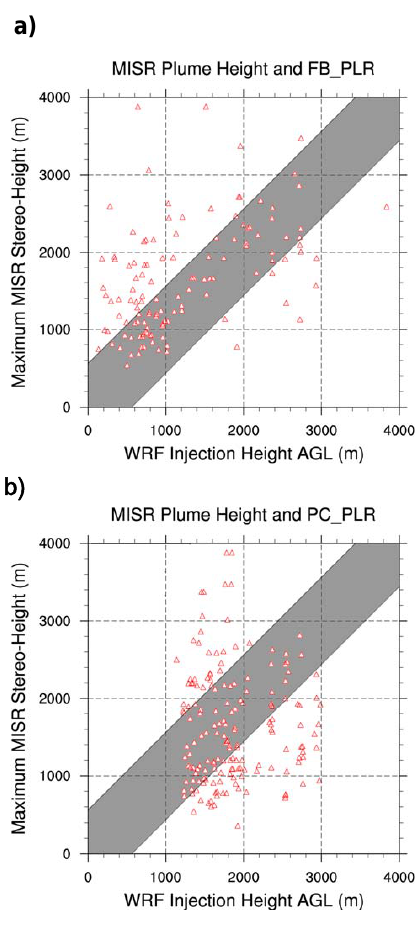
Fig. 3. Injection heights using FB PLR plotted against MISR maxi- Fig. 3. a) Injection heights using FB_PLR plotted against MISR maximum stereo-heights for the mum stereo heights for the entire ten day model run. The Spearman entire ten day model run. The Spearman correlation is 0.45. b) Same as a), but based on PC_PLR. The Spearman correlation is 0.07. Shaded regions represent a hypothetical perfect correlation with correlation is 0.45. (b) Same as (a) , but based on PC PLR. The MISR when assuming a stereo-height error of ± 560 m. Spearman correlation is 0.07. Shaded regions represent a hypothet- ical perfect correlation with MISR when assuming a stereo height error of ±